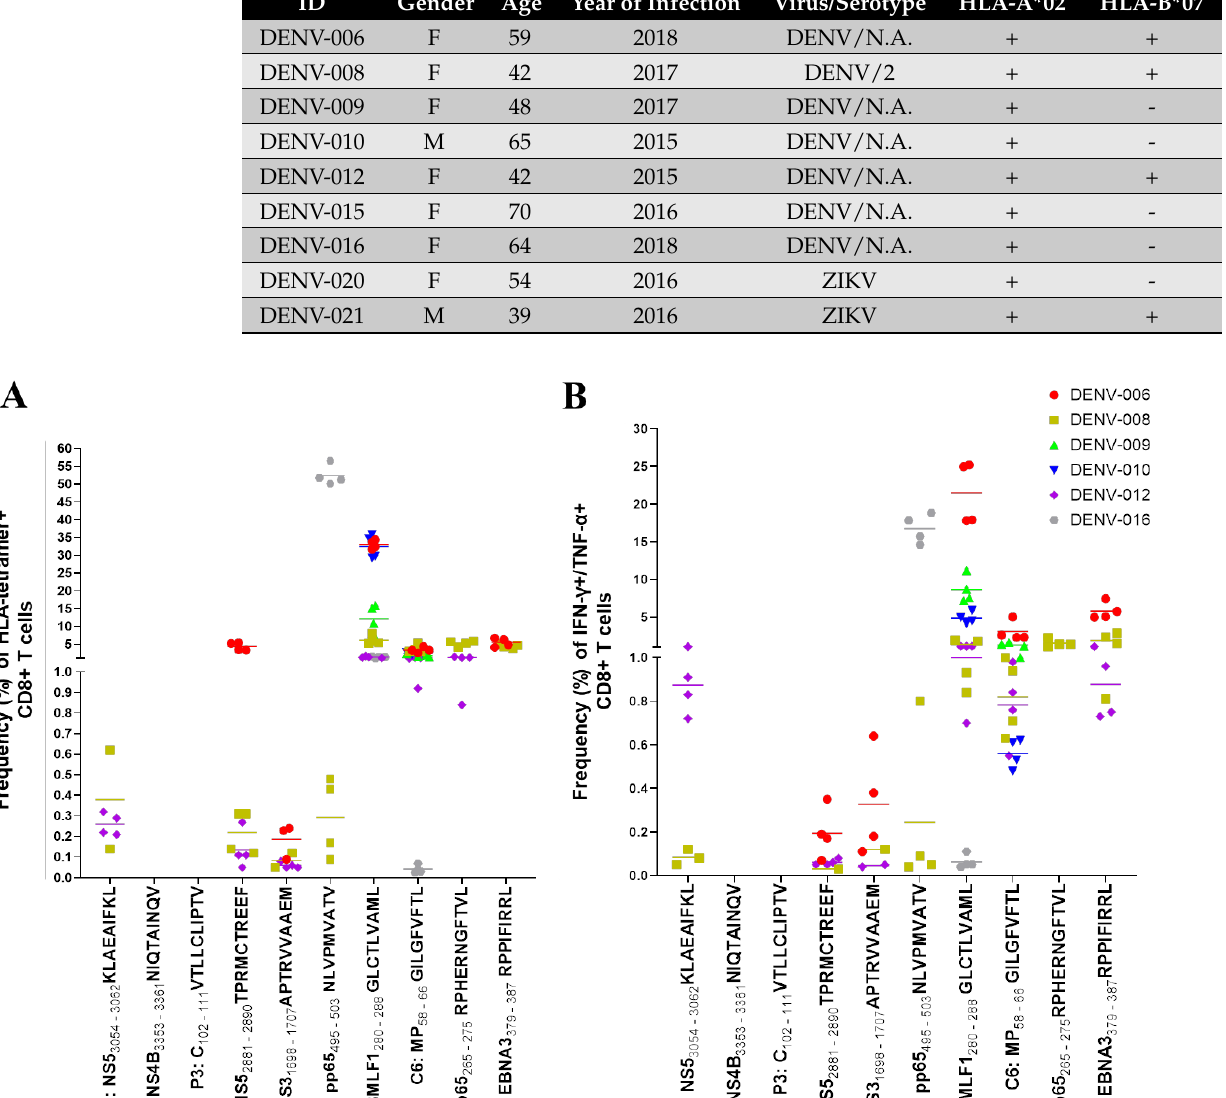
Table 3. Demographic information for donors with laboratory-confirmed DENV or ZIKV. Blood sam- ples from 18 individuals were analyzed and PBMCs from nine donors were identified as HLA-B*07- and/or HLA-A*02-positive. DENV serotypes were examined previously for one participant only.